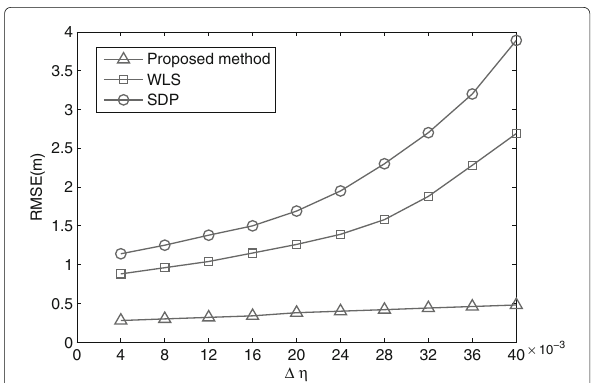
Fig. 12 Localization accuracy for three compared methods when (cid:6)η varies from 0.004 to